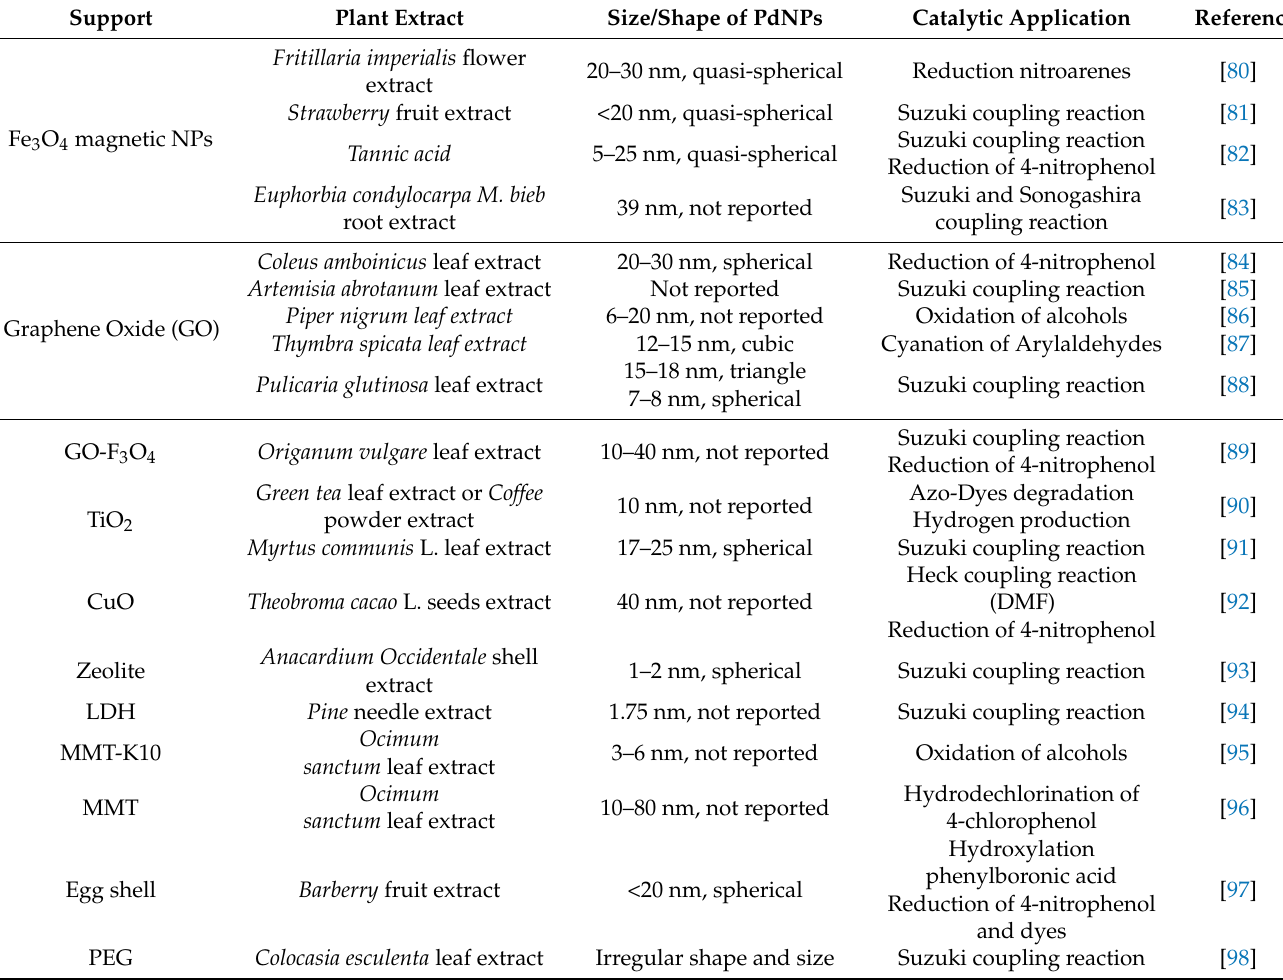
Table 2. Plant extract as reducing and stabilizing agent for PdNPs production on the surface of solid supports.